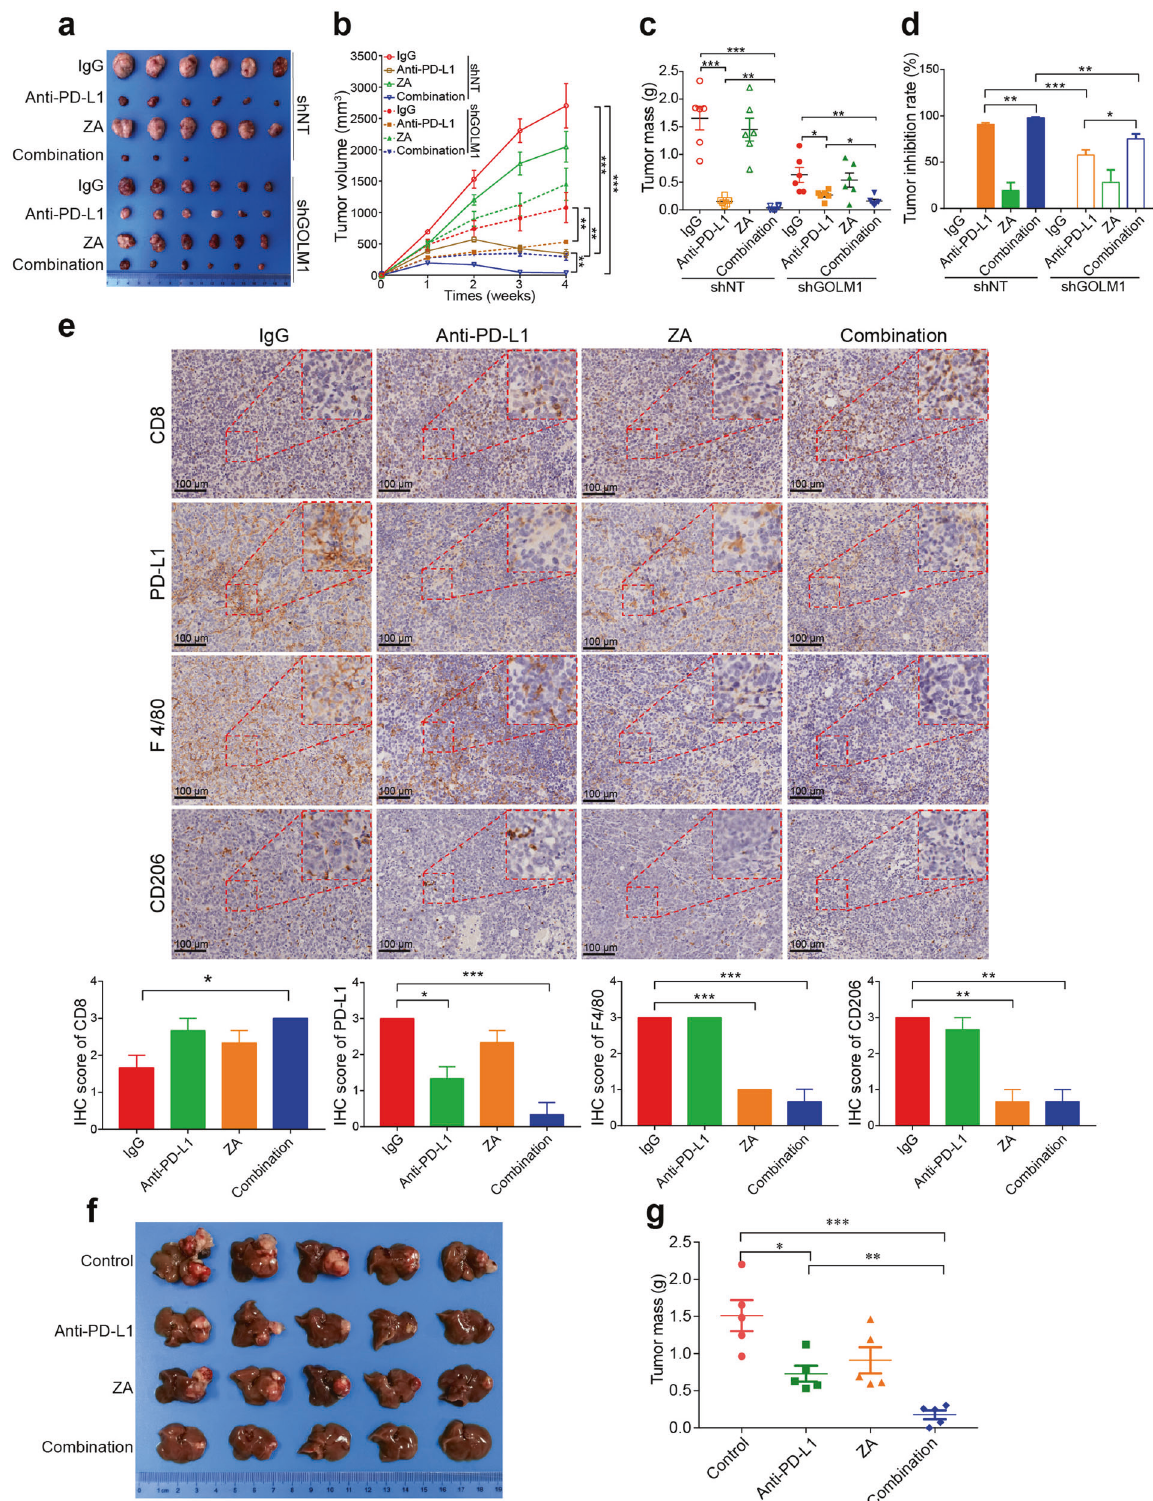
Fig. 6 Inhibition of TAM in fi ltration enhances the ef fi cacy of anti-PD-L1 immunotherapy in HCC mouse model. a – d The inhibitory effects of anti-PD-L1 Ab on tumor growth in subcutaneous implantation C57BL/6 mouse model using Hepa1-6 shNT or Hepa1-6 shGOLM1 cells. When tumor size was 40 mm 3 , mice were treated with IgG isotype control, anti-PD-L1 antibody (200 μ g i.p. injection every 3 days), ZA (100 μ g/kg i.p. injection every 3 days), and anti-PD-L1 antibody in combination with ZA until the treatment endpoint. Representative images of subcutaneous tumors ( a ), tumor growth curves ( b ), tumor weight ( c ), and tumor inhibition rate ( d ) for indicative groups ( n = 6 mice/group). e Representative images and quanti fi cation of IHC staining of PD-L1, CD8, F4/80, and CD206 in hepa1-6 shNT subcutaneous tumors ( n = 3 per group). f , g Representative images and tumor weight analysis in orthotopic implantation models of Hepa1-6 shNT ( n = 5 mice/group). * P < 0.05, ** P < 0.01, *** P < 0.001, ns: no signi fi